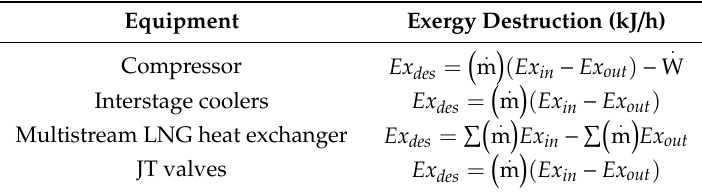
Table 4. Exergy destruction calculations